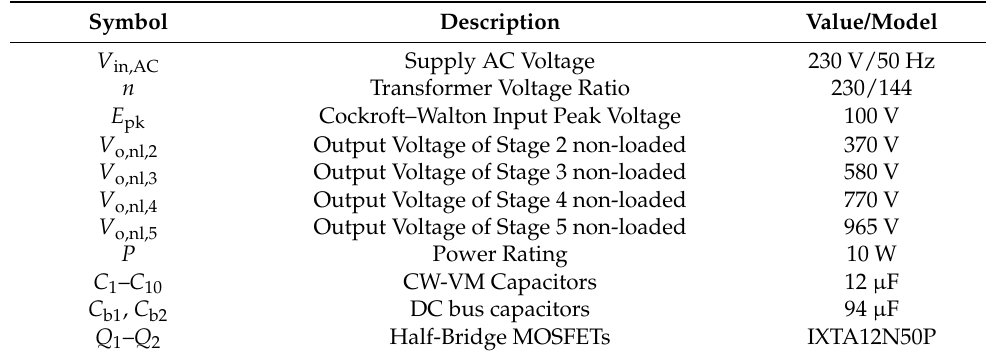
Figure 9. Power converter device for PID emulation and regeneration of PV cells. Table 1. Converter design specifications.